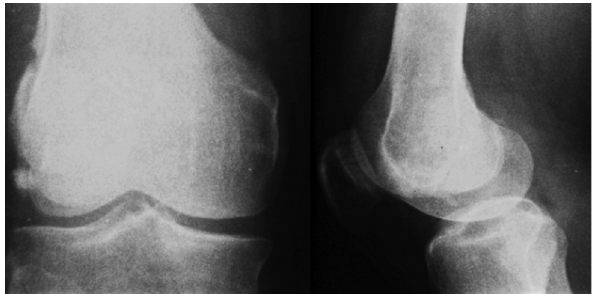
Pre-operative radiograph showing Hoffa fracture. Fig. 1: